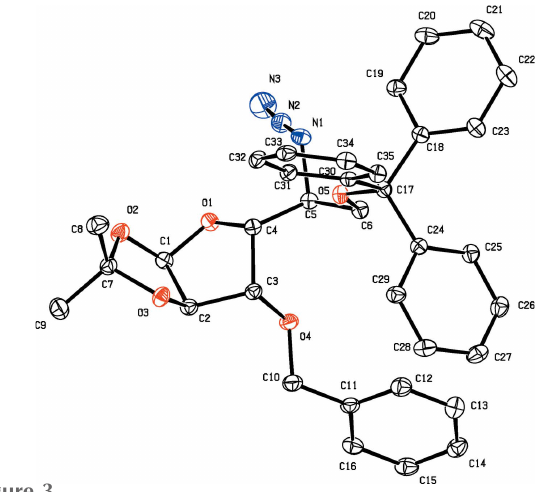
Figure 3 Aview of the molecular structure of compound 4 , with atom labelling and displacement ellipsoids drawn at the 30% probability level. For clarity, H atoms have been